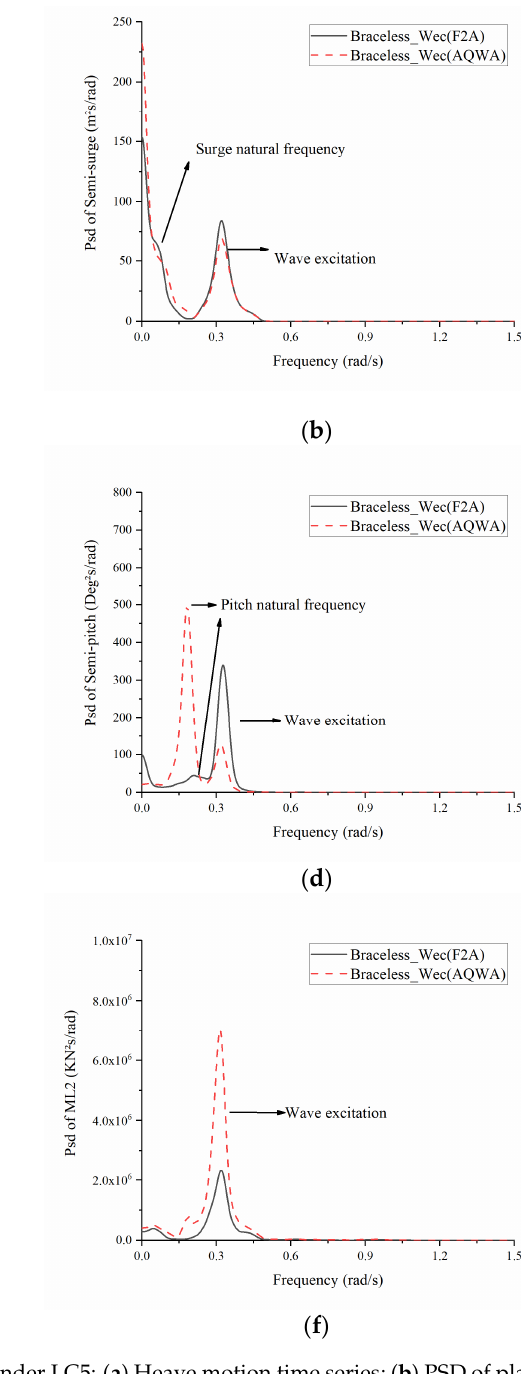
Figure 16. Motion and mooring force response of the platform under LC5: ( a ) Heave motion time series; ( b ) PSD of platform surge; ( c ) PSD of platform heave; ( d ) PSD of platform pitch; ( e ) PSD of ML1; ( f ) PSD of ML2.